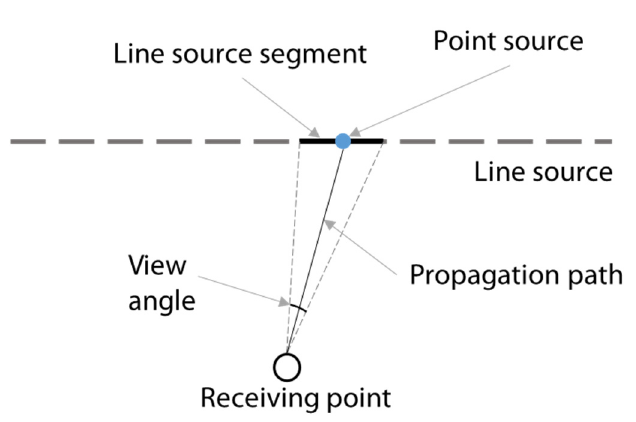
Figure 2. Road noise source and noise segment (modified from [7]).